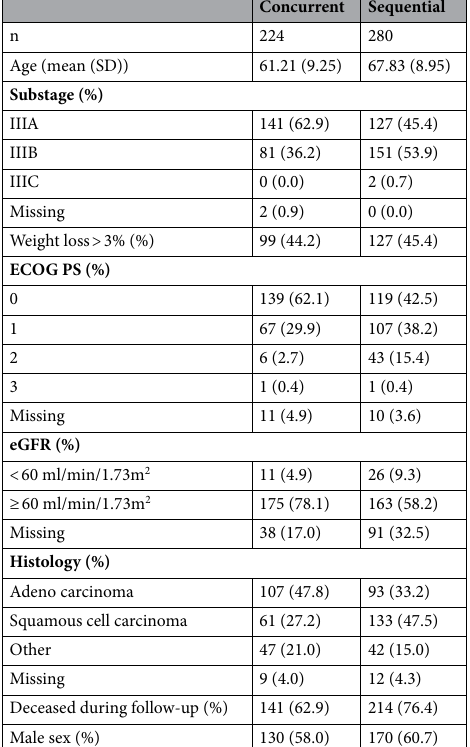
Table 1. Baseline characteristics stratified by chemoradiation type: concurrent chemoradiation or sequential chemoradiation. Weight loss is defined as weight loss over 3% of the original weight over the six months